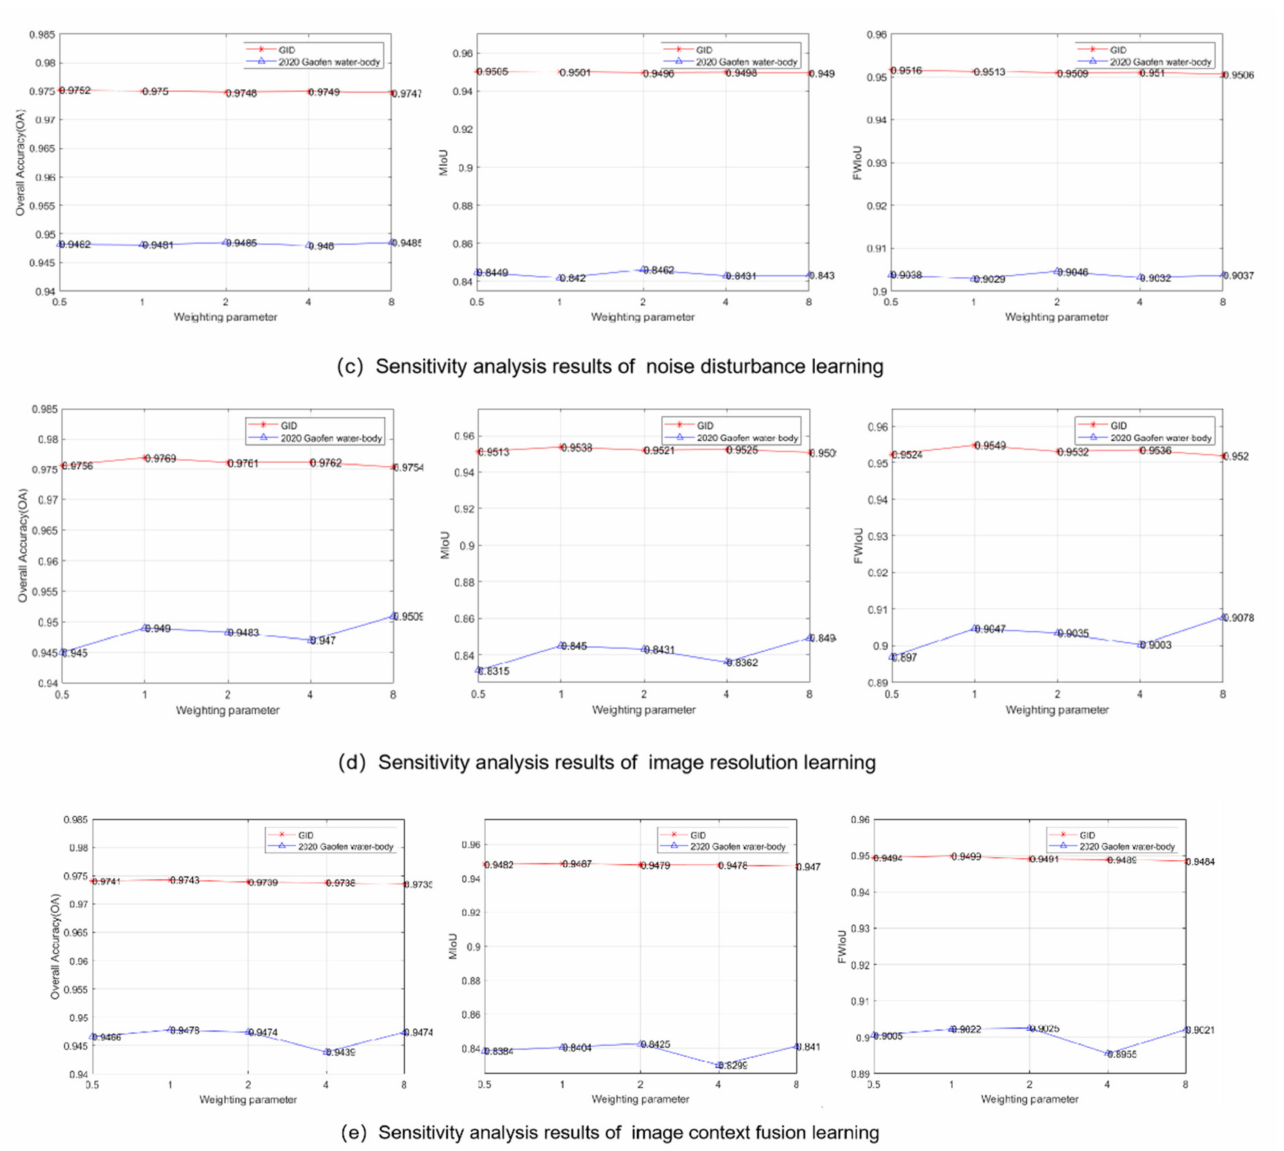
Figure 7. The sensitivity analysis results of five different SSL strategies we proposed, including ( a ) sensitivity analysis results of rotation transformation learning, ( b ) sensitivity analysis results of flip transformation learning, ( c ) sensitivity analysis results of noise disturbance learning, ( d ) sensitivity analysis results of image resolution learning, and ( e ) sensitivity analysis results of image context fusion